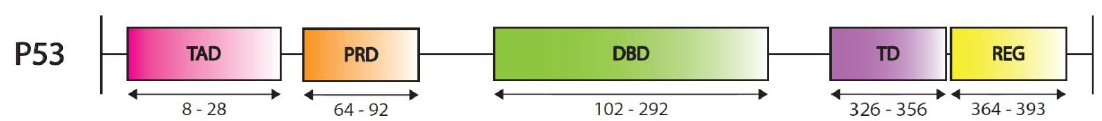
Figure 3. Schematic overview of the P53 protein. Indicated are (from N- to T-terminus) TAD: Transactivation domain, PRD: Proline-rich domain, DBD: DNA-binding domain, TD: Tetramerization domain and REG: Regulatory domain. Numbers indicate the amino acids included in each domain.